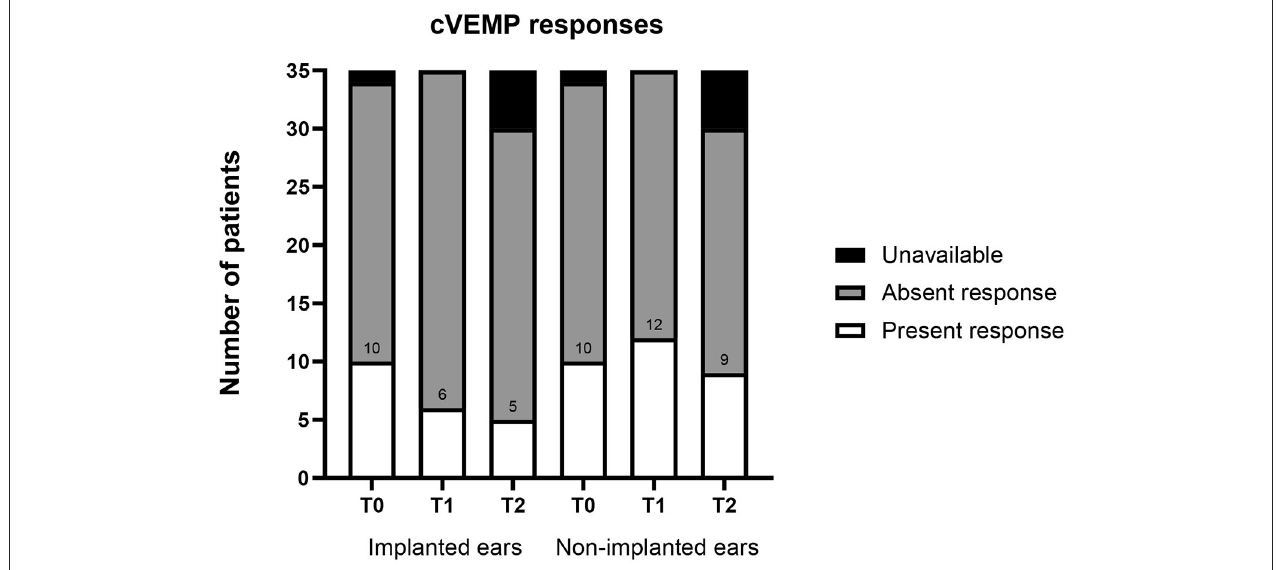
FIGURE 6 | Pre- and postoperative cVEMP responses for implanted and non-implanted ears ( n = 35). T0, baseline before implantation; T1, first postoperative follow-up; T2, second postoperative follow-up; cVEMP, cervical evoked myogenic potentials. Numbers indicate number of present responses.